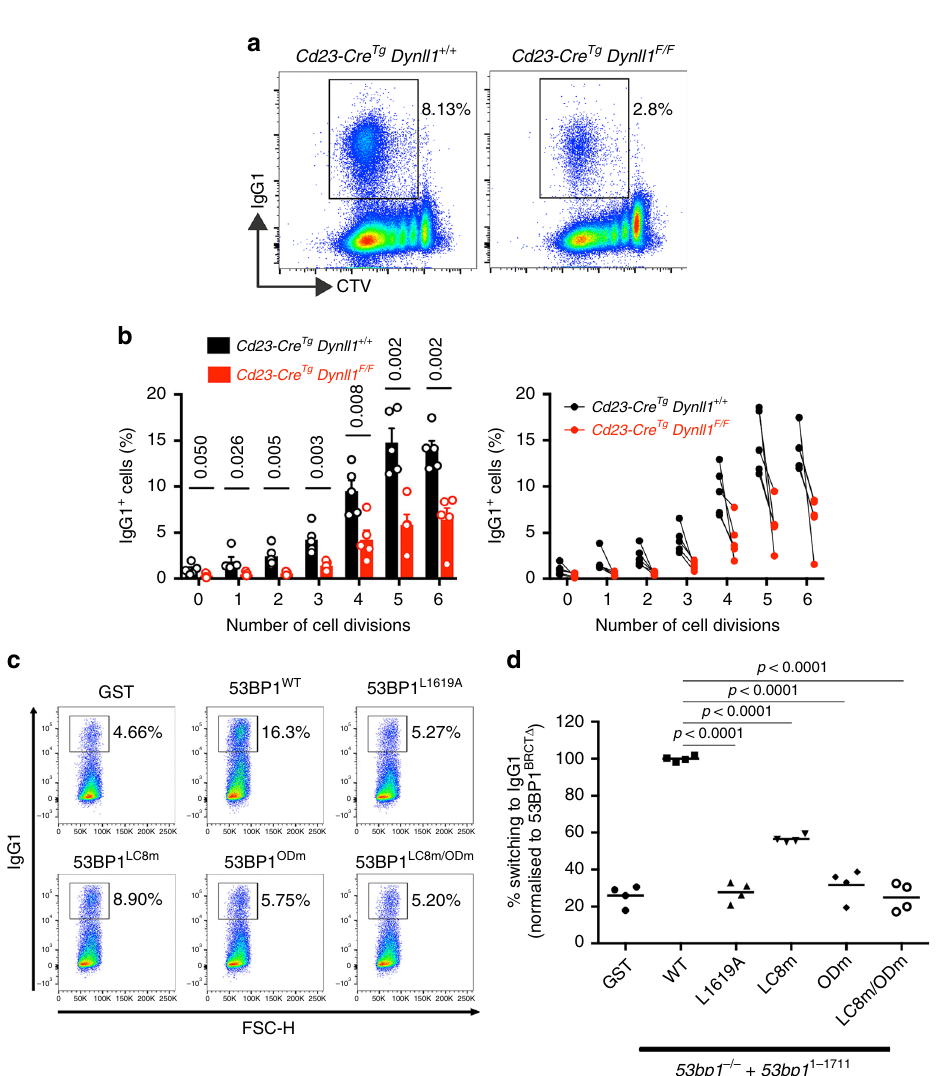
Fig. 2 53BP1-dependent class-switch recombination requires DYNLL1. a In vitro CSR to IgG1 in Dynll1 F/F Cd23-Cre Tg and control Cd23-Cre Tg mature B splenocytes, 96 h following stimulation with LPS and IL-4. Representative fl ow cytometric plots depict IgG1 positive fraction of cells, in cells co-stained with CellTrace Violet (CTV). b IgG1-positive (IgG1 + ) B cells as a proportion of total B cells (%) for each cell generation as determined by CTV staining and proliferation-associated dye dilution. Signi fi cance was determined by unpaired two-tailed student ’ s t-test with Holm-Sidak correction for multiple comparisons. Data, n = 5 mice, mean ± SEM. c In vitro CSR to IgG1 in mature B splenocytes from 53bp1 -/- mice, 96 h following stimulation with LPS and IL-4, and 72 h following retroviral complementation as indicated. Representative plots. d Quanti fi cation of (C). Bars represent mean, n = 4